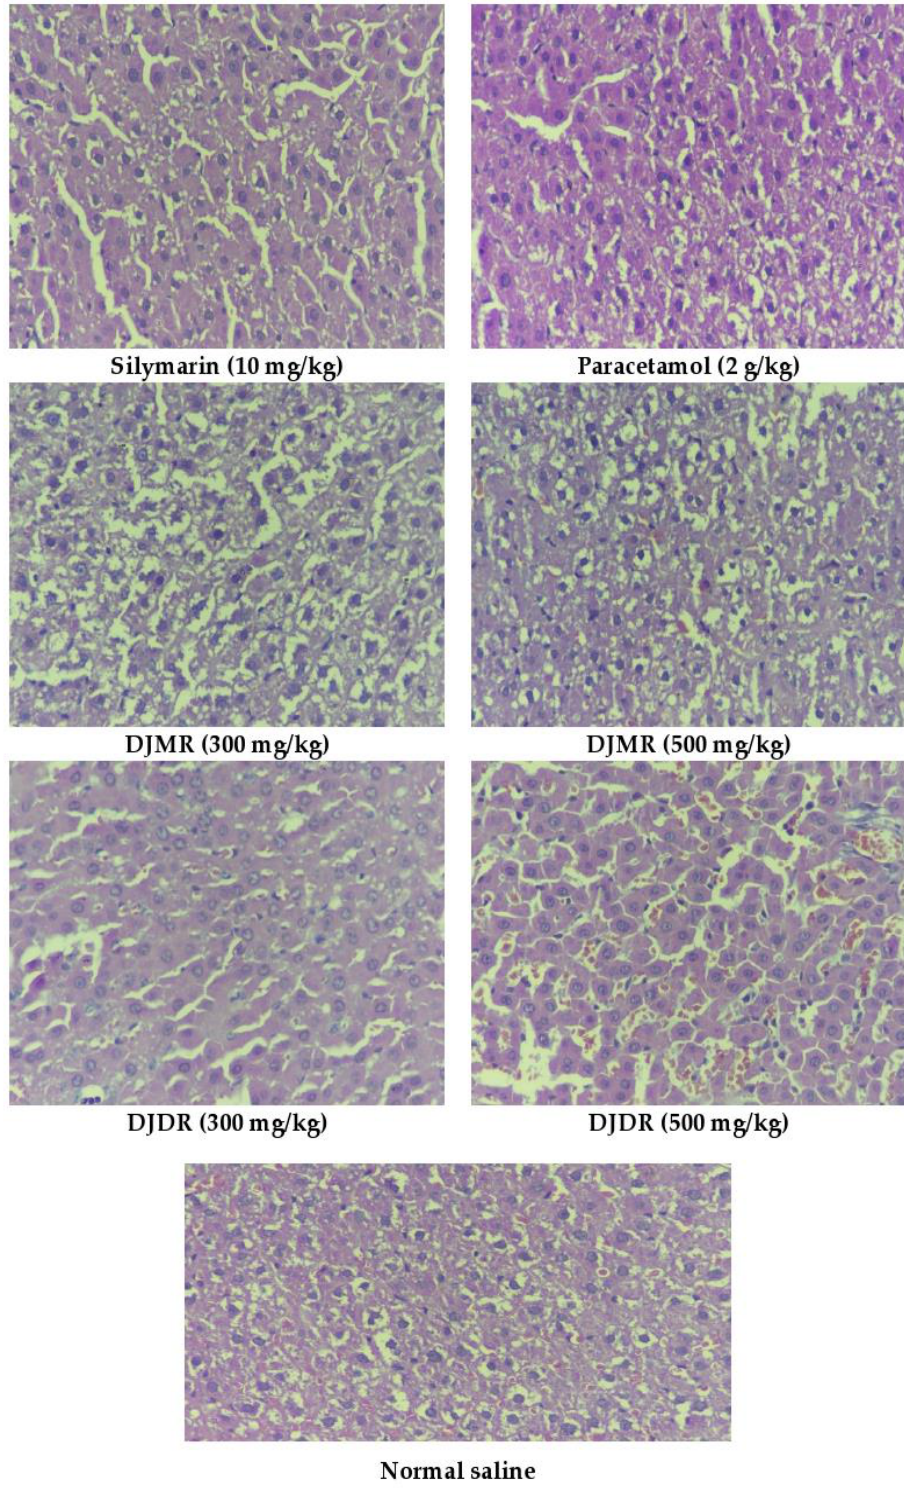
Figure 4. Histopathological analysis of liver. DJDR, Dryopteris juxtapostia methanol root; DJMR, Dryopteris juxtapostia dichloromethane root .